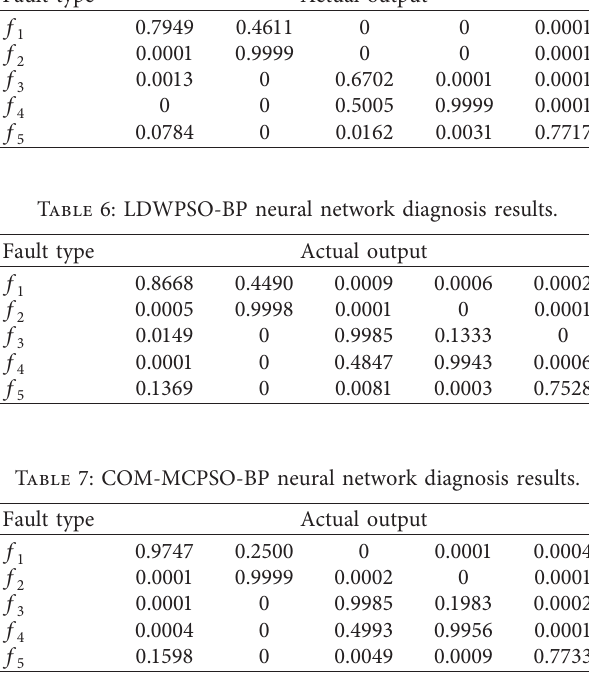
Table 5: PSO-BP neural network diagnosis results. Fault type